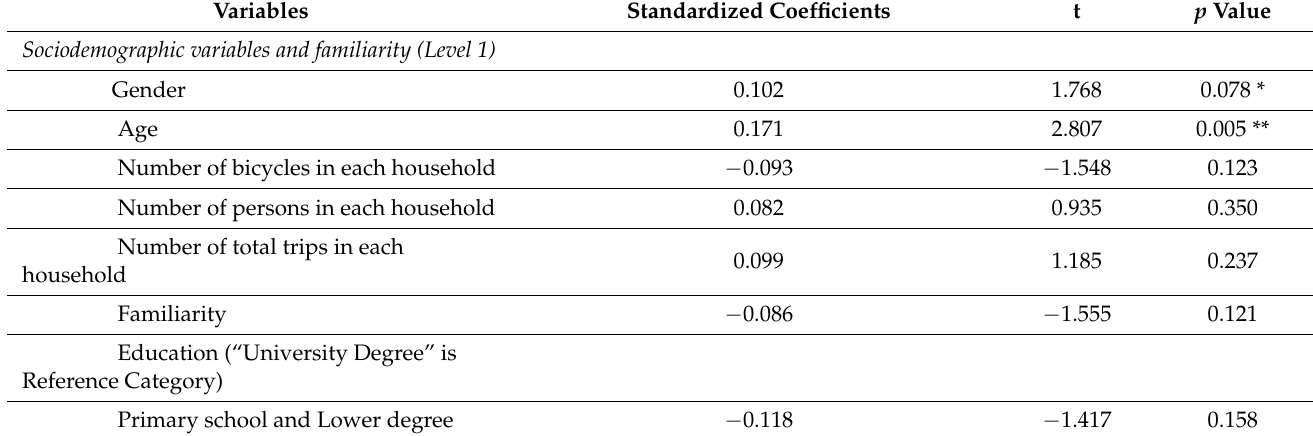
Table 4. The results of hierarchical multiple regression analysis for predicting walking to workplaces (N =